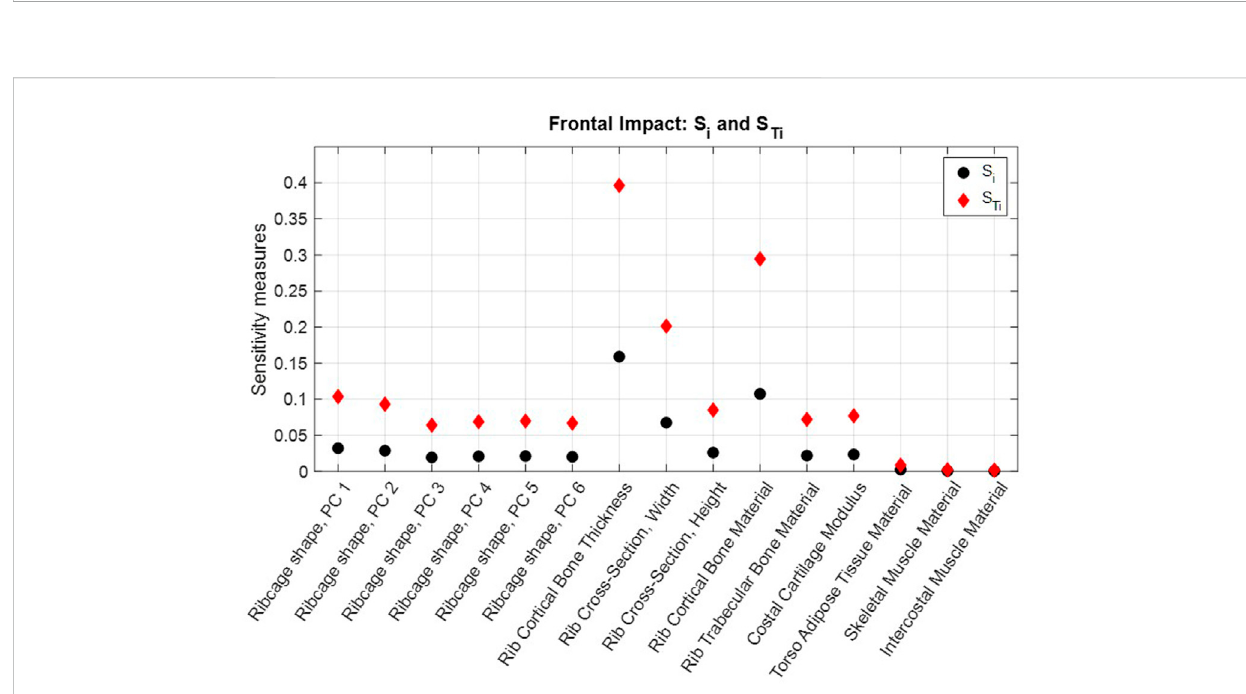
Frontal impact NFR2+ fi rst-order sensitivity indices S i (black dots) and total sensitivity indices, S Ti (red diamonds) calculated for each